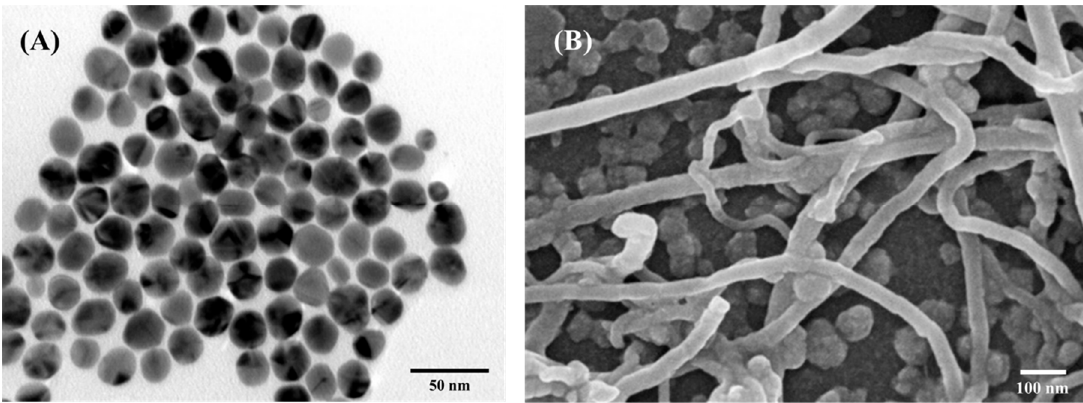
Figure 1. ( A ) TEM image for AgNPs; ( B ) SEM image for MWCNTs.